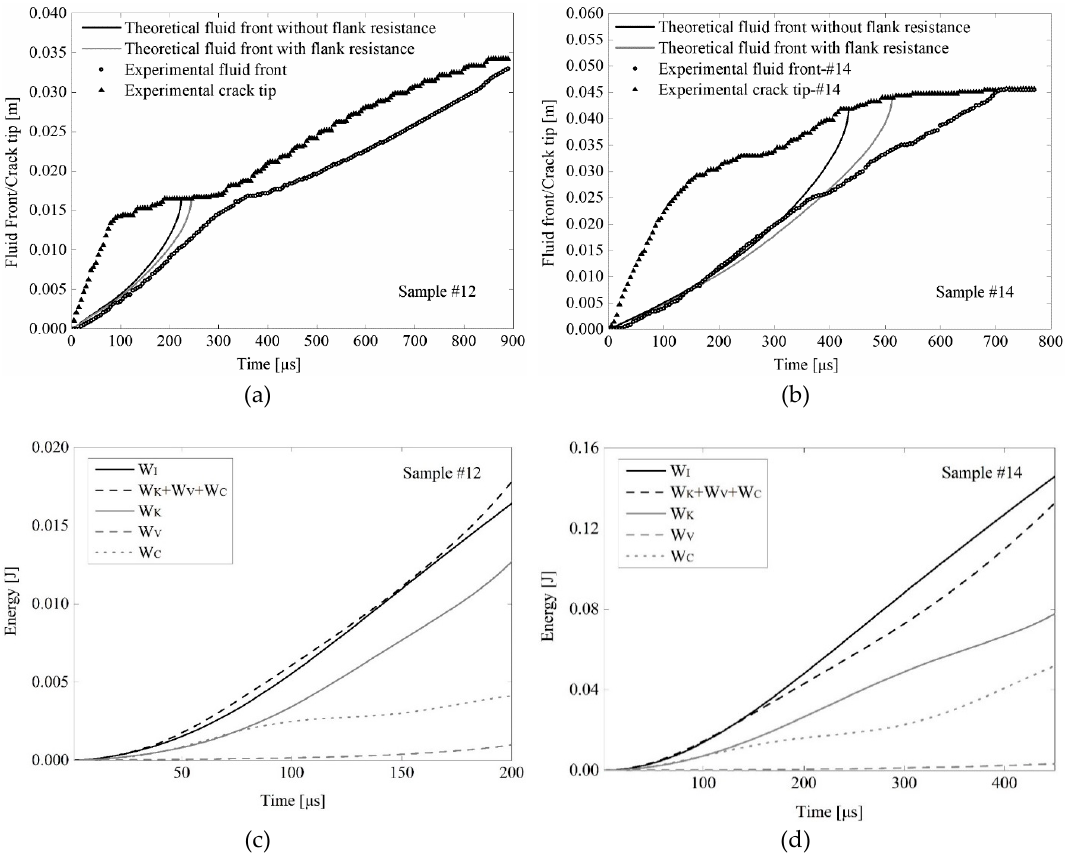
Figure 6. ( a ) and ( b ) are the comparison between experimental results and theoretical results of fluid front for sample #12 (fracturing pressure: 2.74 MPa) and sample #14 (fracturing pressure: 4.06 MPa) respectively. The fluid front positions are the numerical results by solving Equation (22) with and without the term of the crack flank resistance. The calculations with the crack flank resistance term provide better results of the fluid front position; ( c ) and ( d ) are corresponding energy as a function of time. The energy terms are calculated using the equations from Equation (23) to Equation (26). The kinetic energy W K of the fluid occupies around half of the total energy. The work done by the fluid on the crack flank is a non-negligible part of the total energy. The input energy and the consumed energy conform well to each other.